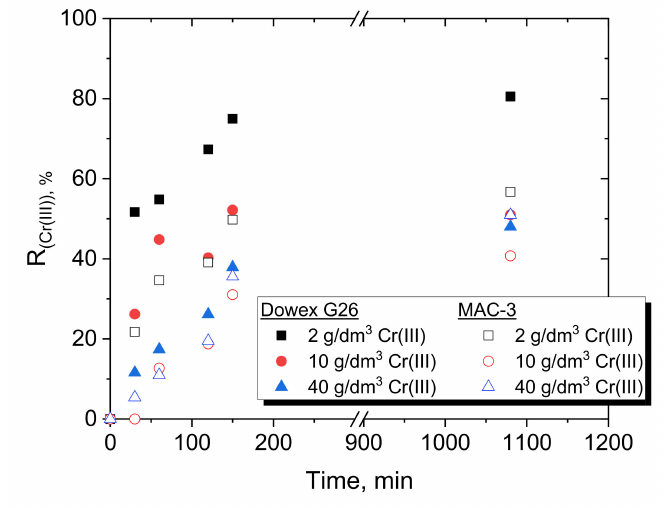
Figure 3. Cr(III) adsorption from model sulfate solution with various amounts of ( a ) Dowex G26 and ( b ) MAC-3 resins (feed: 2 g/dm 3 Cr(III), 3 M H + , L/S = 1/250 cm 3 /mg).